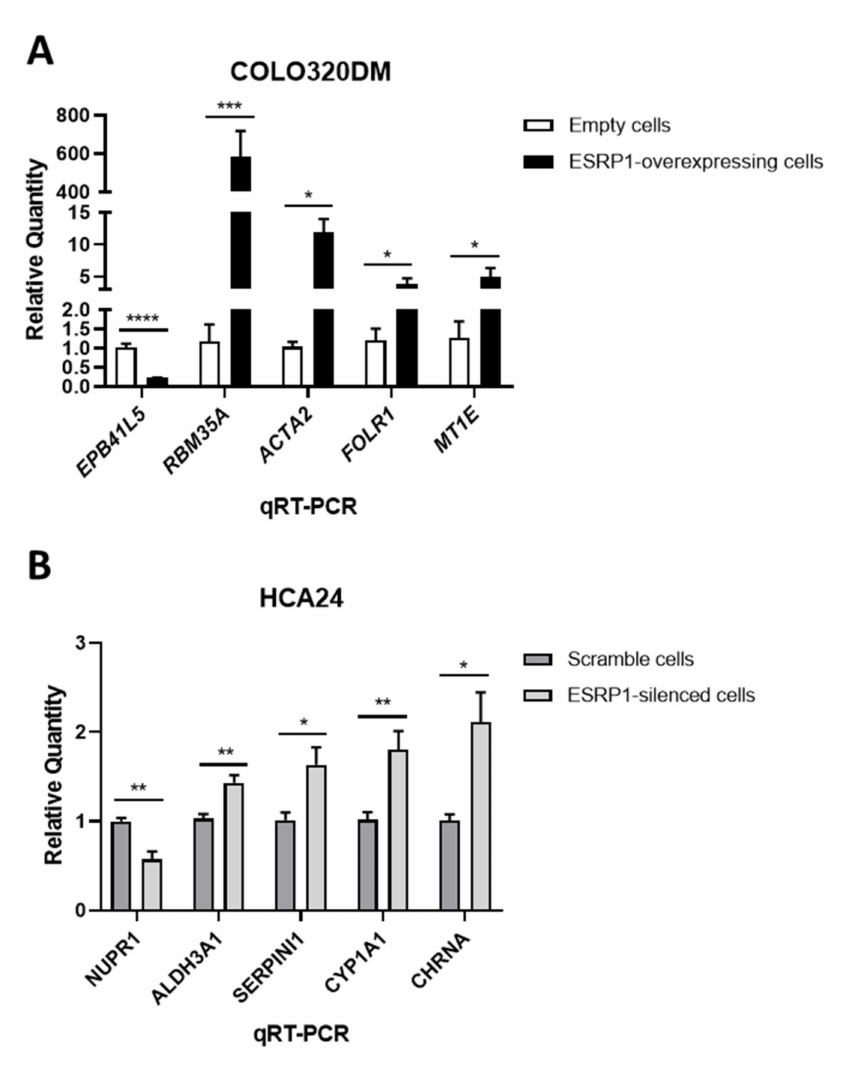
Figure 2. Microarray data validation. ( A ) Gene expression levels of EPB41L5 , RBM35A ( ESRP1 ), ACTA2 , FOLR1 and MT1E in ESRP1-modulated COLO320DM cells ( n = 6). ( B ) Gene expression levels of NUPR1 , ALDH3A1 , SERPINI1 , CYP1A1 and CHRNA in ESRP1-modulated HCA24 cells ( n = 4). Data are expressed as mean ± SEM of relative quantification using the delta–delta Ct method over control (empty and scramble in COLO320DM and HCA24 cells, respectively) cells. Normalization was made using GAPDH as housekeeping gene. Unpaired t-test was performed: * p < 0.05, ** p < 0.01, *** p < 0.001, **** p <